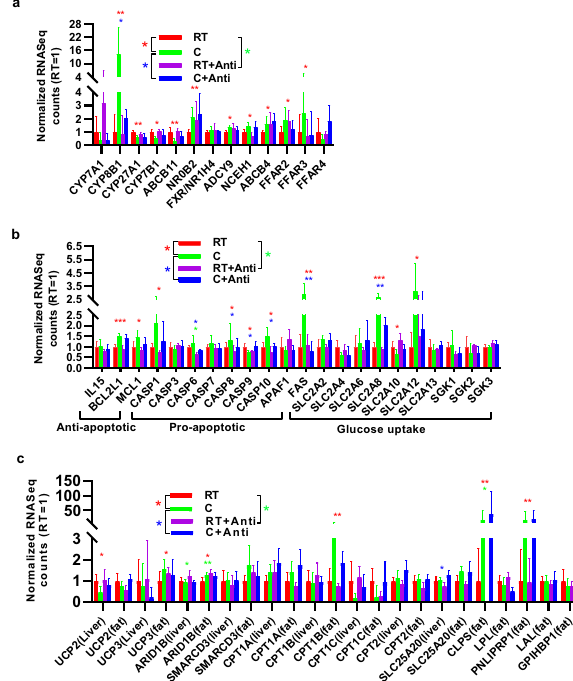
Fig. 6 Relative mRNA expression in the liver or fat quanti fi ed by RNA-seq. a Genes involved in bile acid and short-chain fatty acid metabolism in the liver. b Genes involved in antiapoptotic, proapoptotic, and glucose uptake effects in the liver. c Genes involved in the balance of thermogenesis and fat metabolism. The data are the means ± SEMs ( n = 3 or 5 per group).